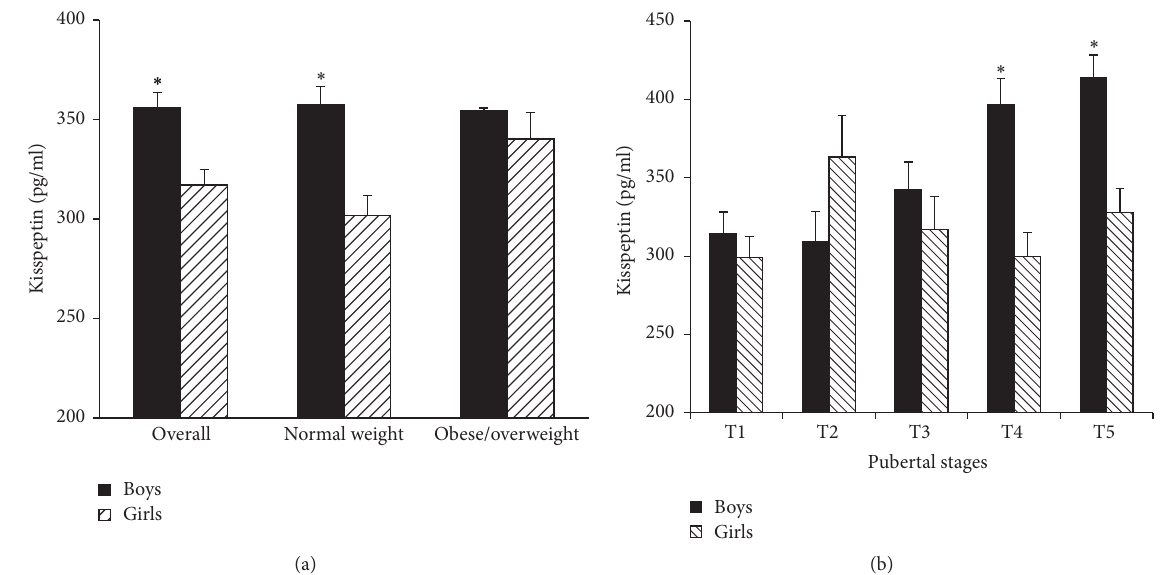
Figure 5: Serum kisspeptin levels between boys and girls in different nutritional states (a) and different pubertal stages (b) ((a) ∗ compared with girls, 𝑃 < 0.01 ; (b) ∗ compared with girls, 𝑃 < 0.05